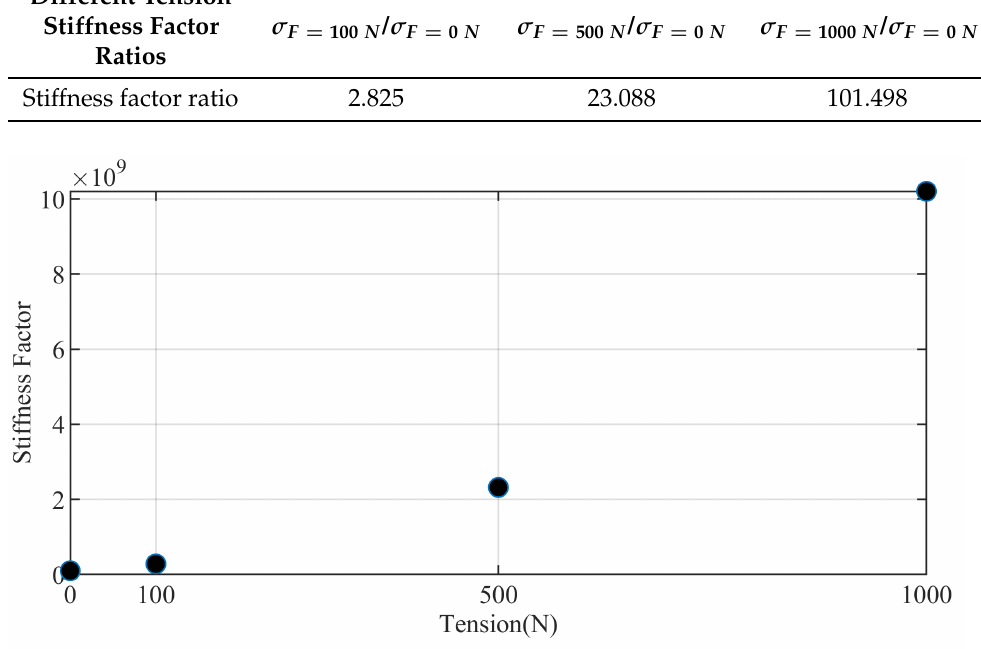
Figure 8. The influence of the driving cable tension on the